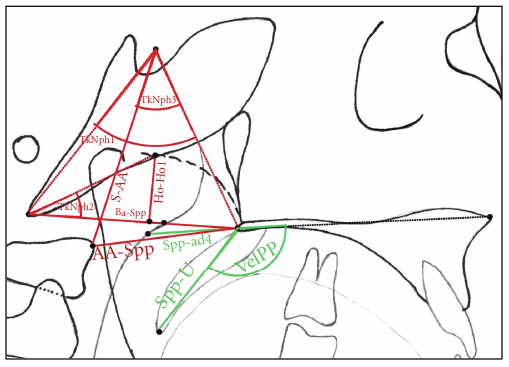
Figure 3: Cephalometric variables of the naso- and oropharyngeal area. (angular measurements: TkNph1: angle Ba-S-Spp, TkNph2: angle Ho-Ba-ad1, TkNph3: angle AA-S-Spp, VelPP: angle Spa-Spp- U; linear measurements are visible in this figure).